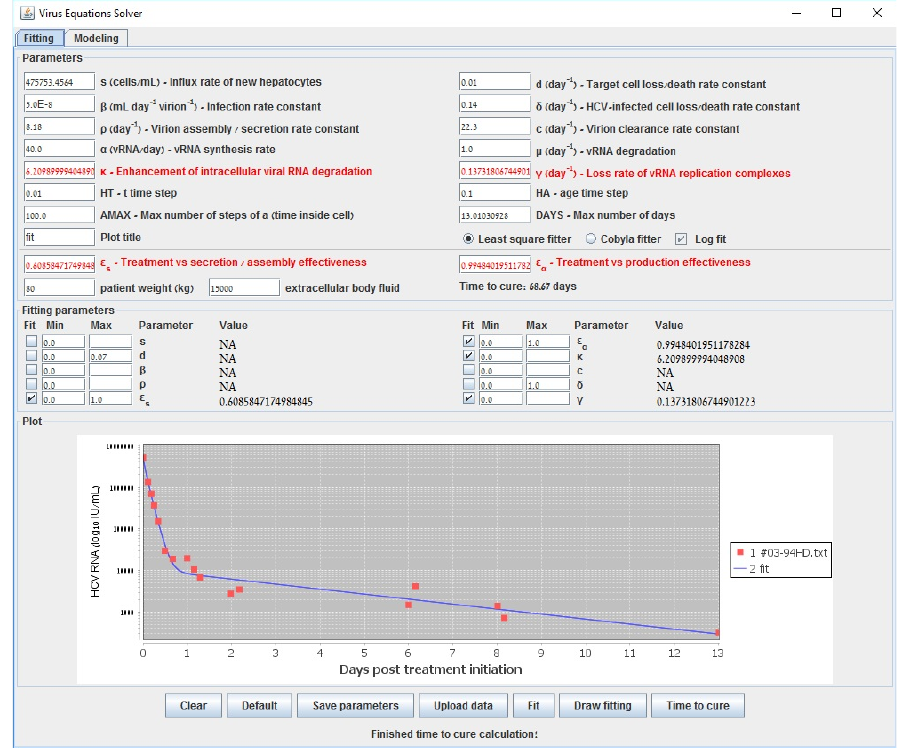
Figure 3. End fit using Gauss–Newton (LSF) that emanates from data of a patient reported in